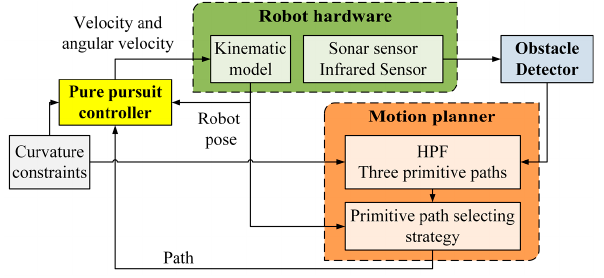
Figure 11. The flowchart of the online obstacle avoidance system for a curvature constrained non-holonomic mobile robot based on the primitive streamline paths, a path selection strategy, and a pure pursuit algorithm for streamline